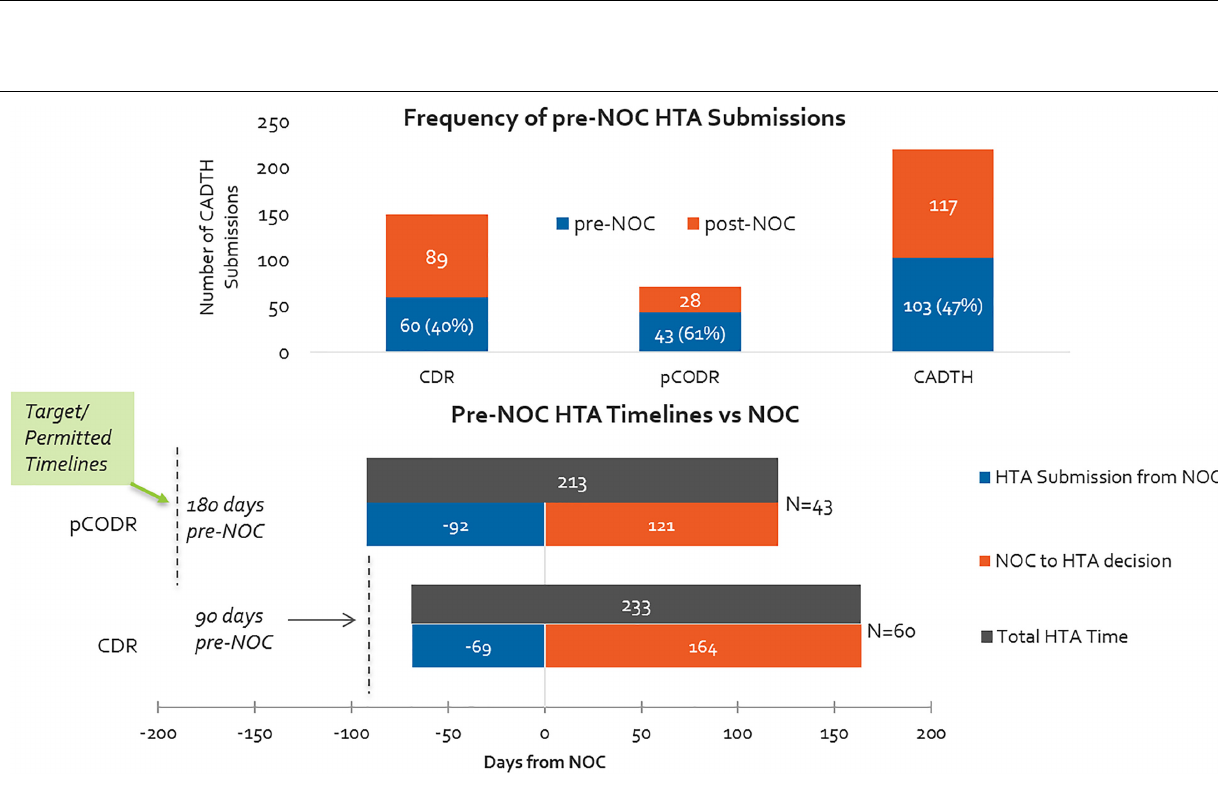
Frontiers in Pharmacology |